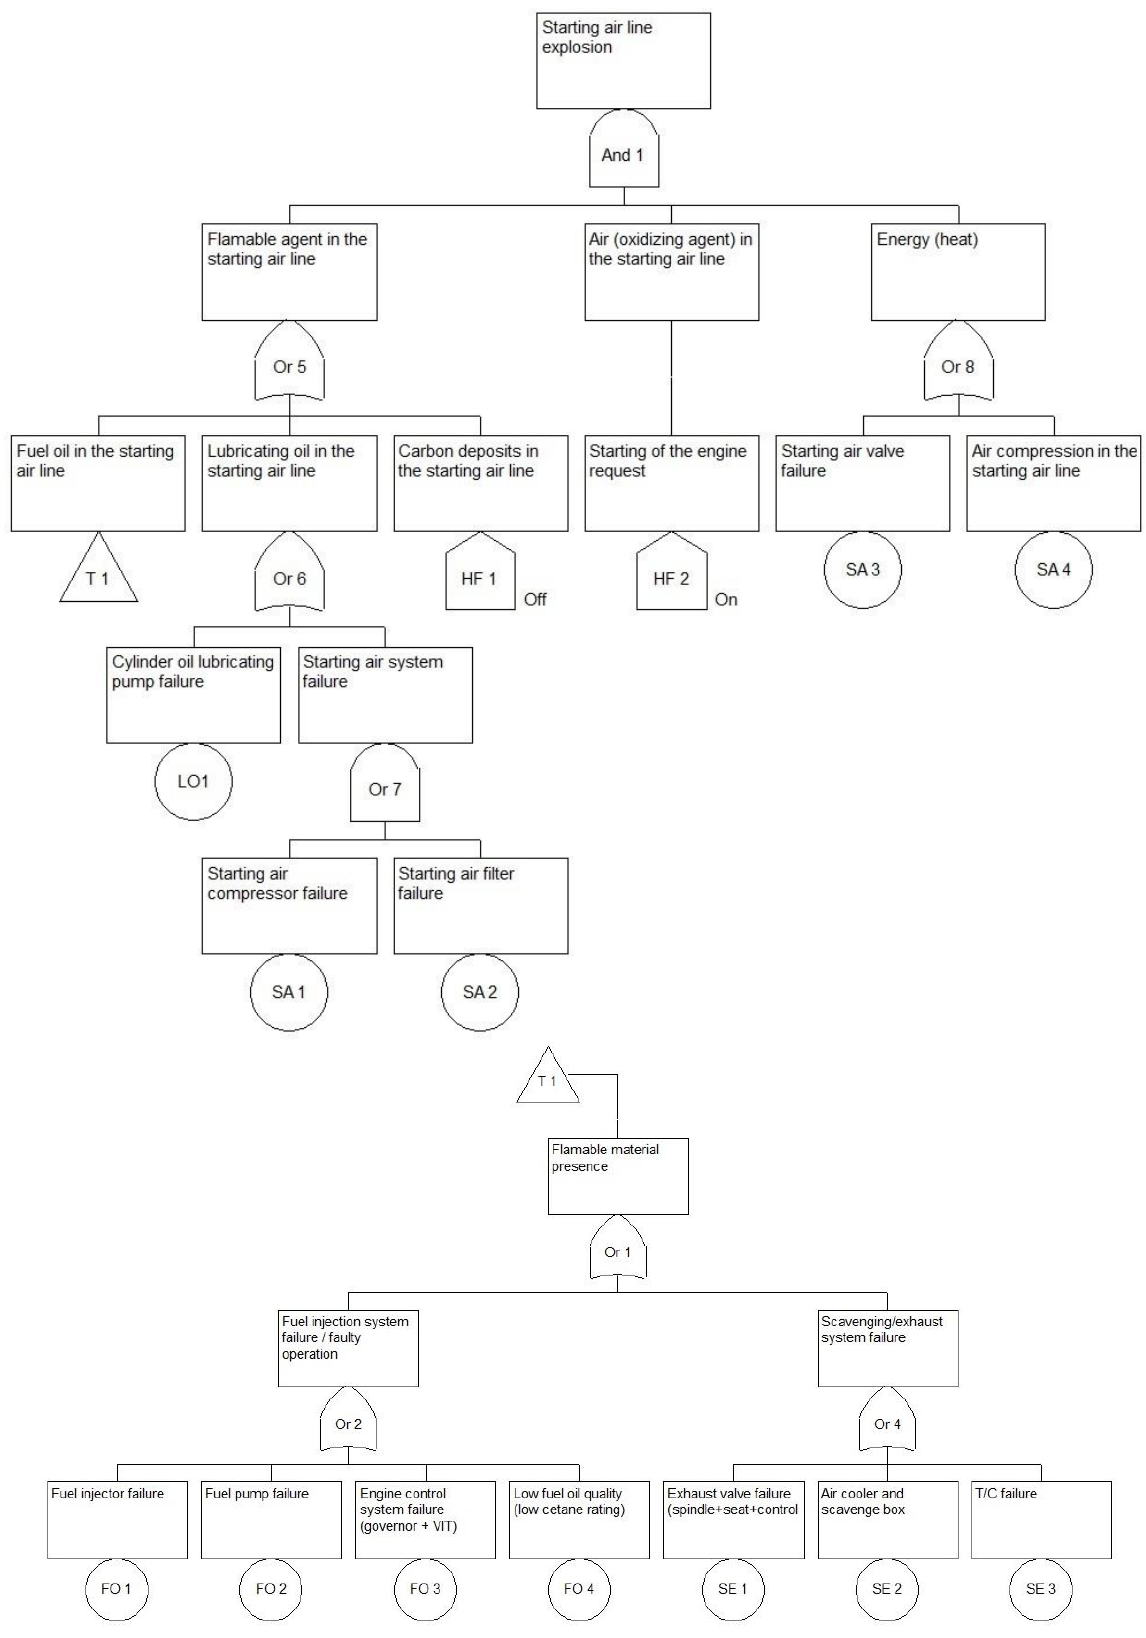
Figure 5. Fault tree modeling of the explosion in the starting air manifold of a slow-speed, internal combustion crosshead engine. combustion crosshead